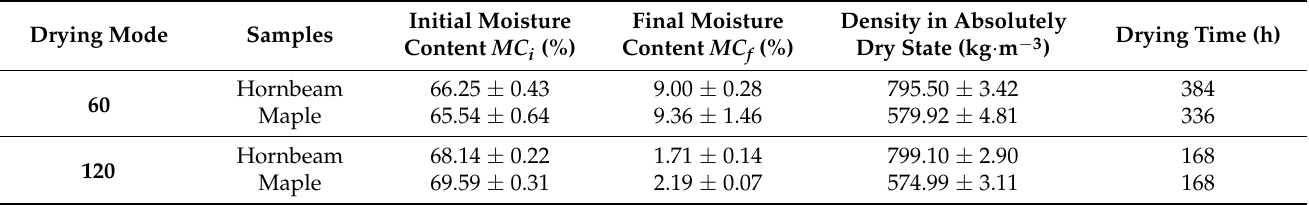
Table 3. Data about drying modes, initial and final moisture contents, density in absolutely dry state and drying